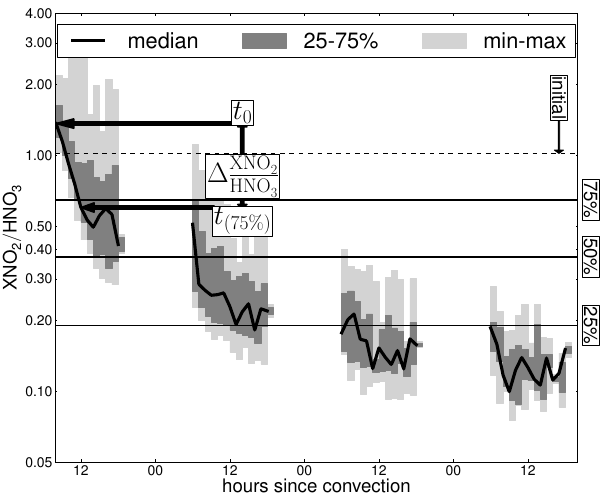
Fig. 3. XNO 2 :HNO 3 (median: line; full range: light gray box; inter- Fig. 3. XNO 2 : HNO 3 (median: line; full range: light gray box; inter-quartile: dark gray box) plotted as a quartile: dark gray box) plotted as a function of hours from simu- lation start. The observed XNO 2 :HNO 3 quartiles are delineated by function of hours from simulation start. The observed NO 2 : HNO 3 quartiles are delineated by horizontal lines. horizontal lines. Components of Eq. (1) are indicated with Components of Eq. (1) are indicated with arrows.